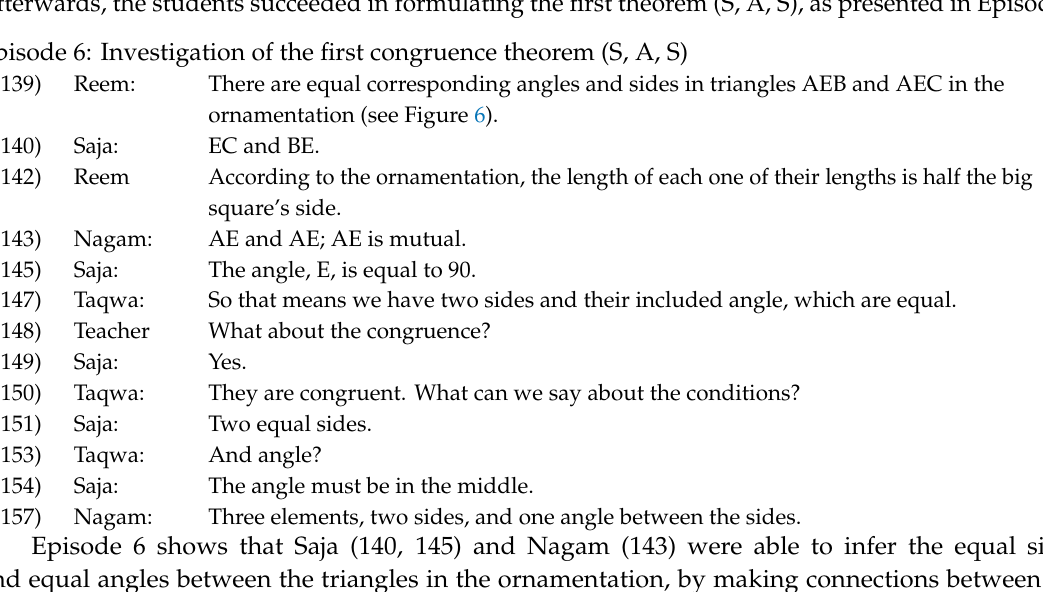
Figure 5. The fifth ornamentation.